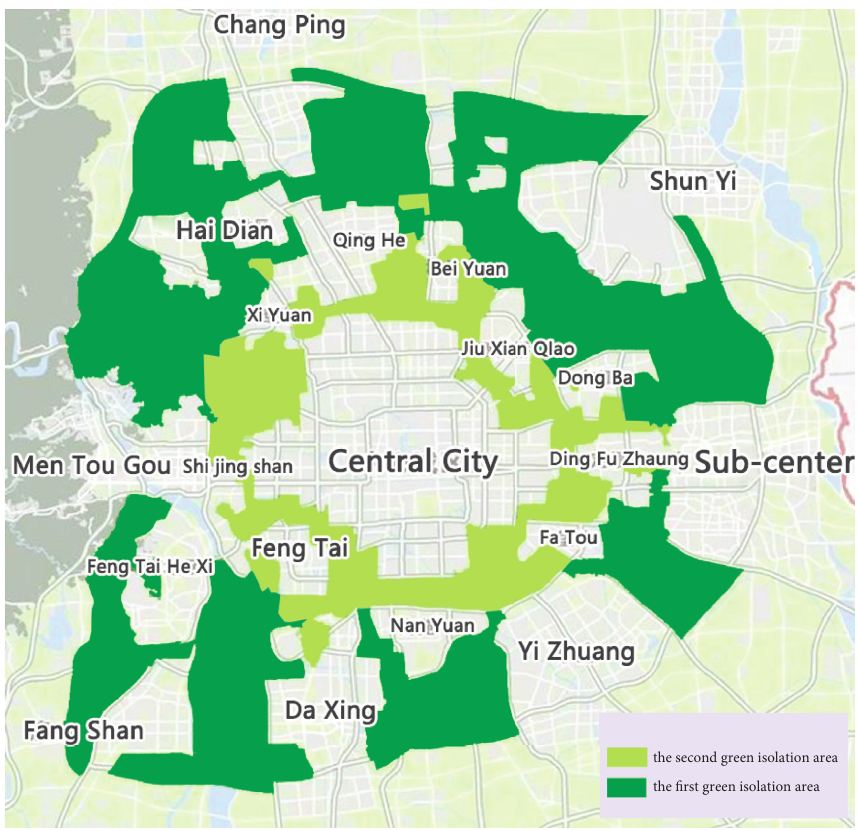
Figure 1: Scope of the first and second green isolation areas